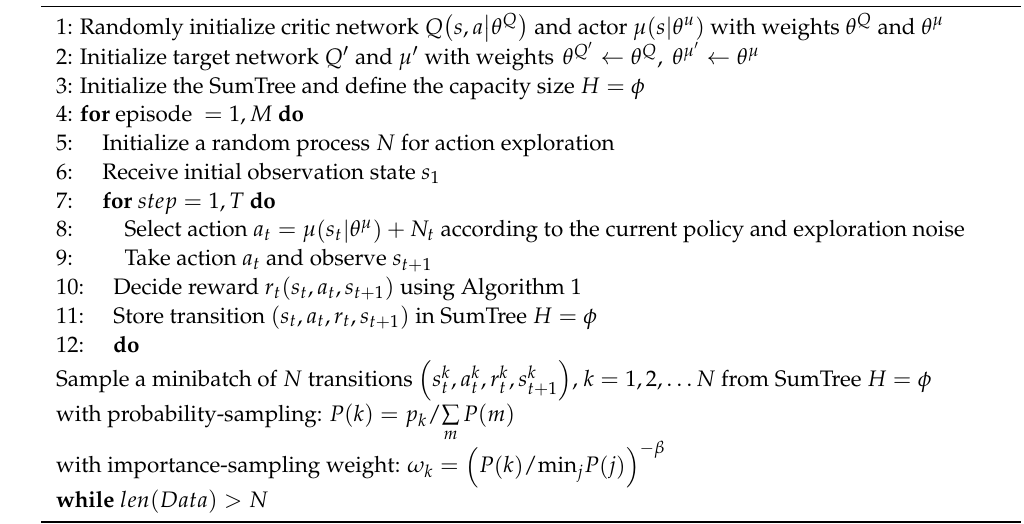
Algorithm 2. SumTree-DDPG